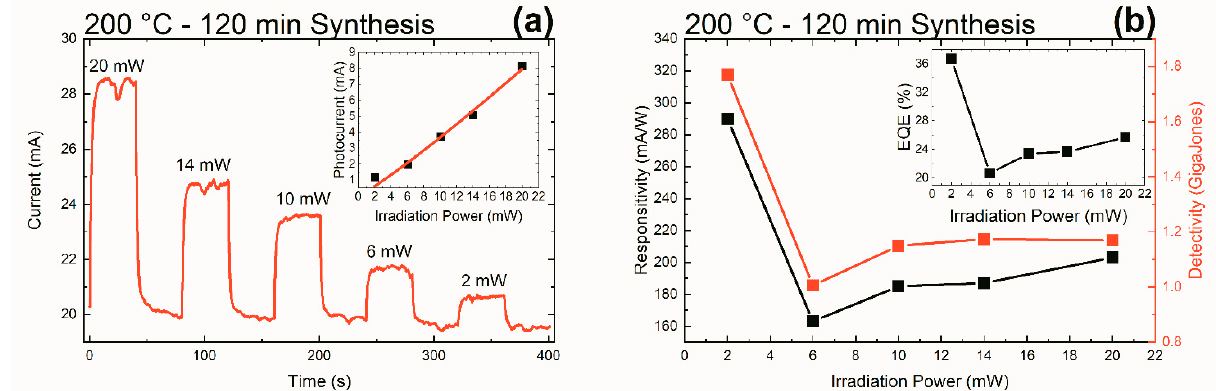
Figure 7. ( a ) Current dependence due to the decrease in the power of the light source (laser 980 nm, ON, OFF) on the sensor. The inset shows the relationship between the generated photocurrent and the irradiation power of the light source on the sensor for the synthesized sample at 200 ◦ C for 120 min. The bias voltage used here was 4 V. ( b ) Responsitivity, Specific Detectivity, and EQE (inset) under different irradiation powers of the device regarding the synthesized sample with a temperature of 200 ◦ C and a time of 120